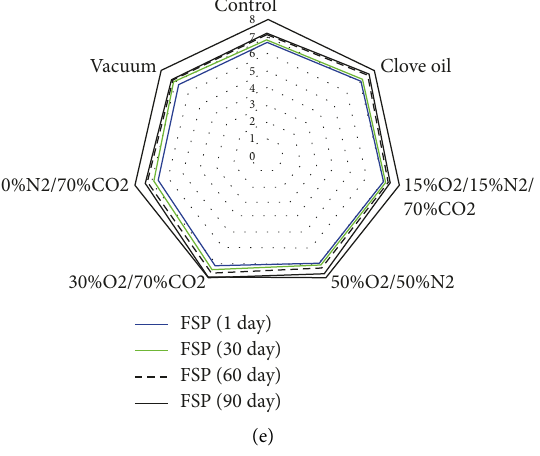
Figure 6: The effect of MAP treatments and FSP on the sensory assessment: (a) color; (b) juiciness; (c) tenderness; (d) flavor; and (e) overall acceptance of